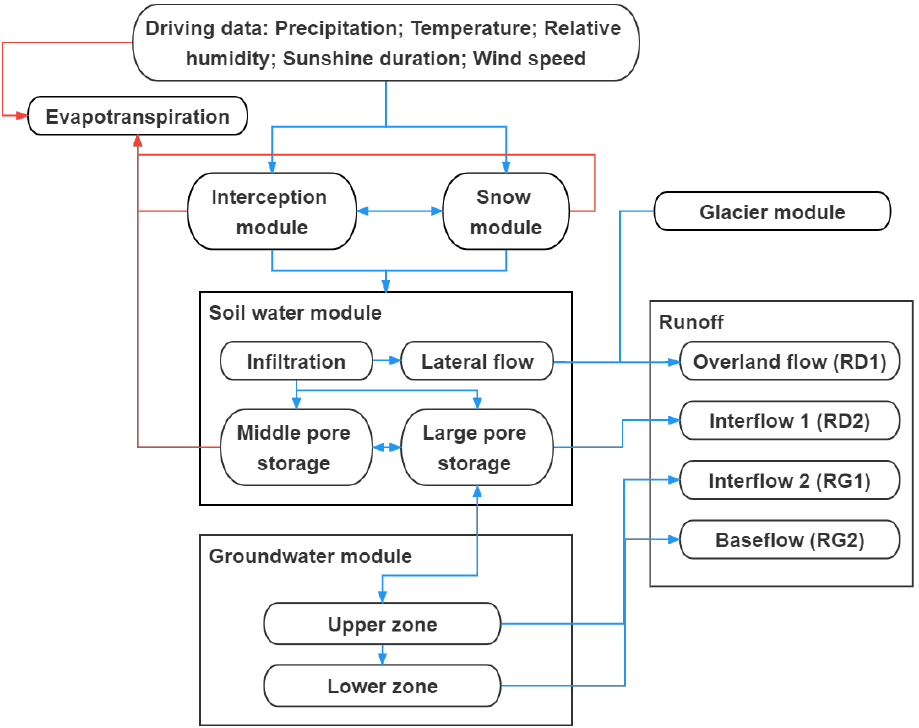
Figure 4. The structure of the J2000 model.